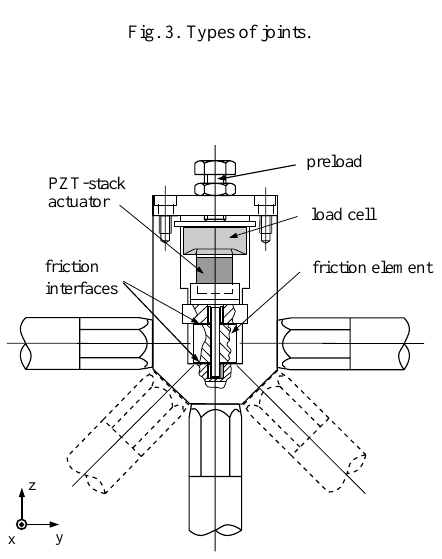
Fig. 3. Types of joints.